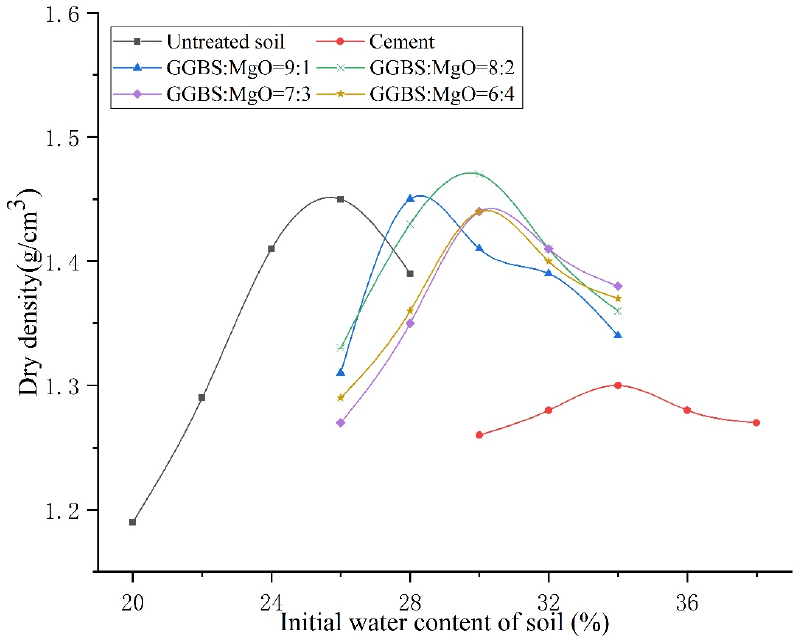
Figure 2. Compaction curves of Mg-sulfate-soil with and without curing agents.